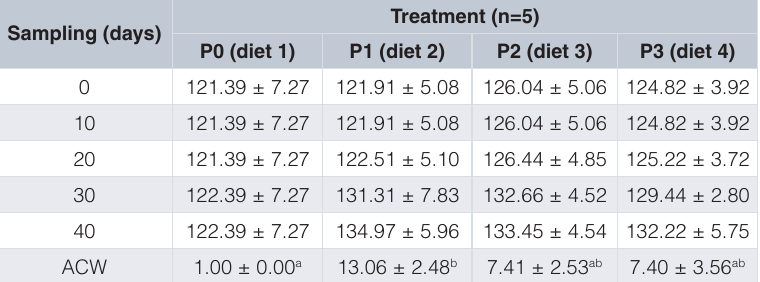
Table 4. Average carapace width (mm) and absolute carapace width (mm) of female broodstock blue swimming crabs, P. pelagicus (Linnaeus, 1758), with a formulated diet of vitamin E supplementation at different